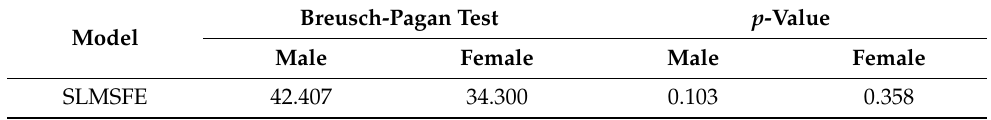
Table 7. Values of the Breusch-Pagan statistic and p -values by sex.